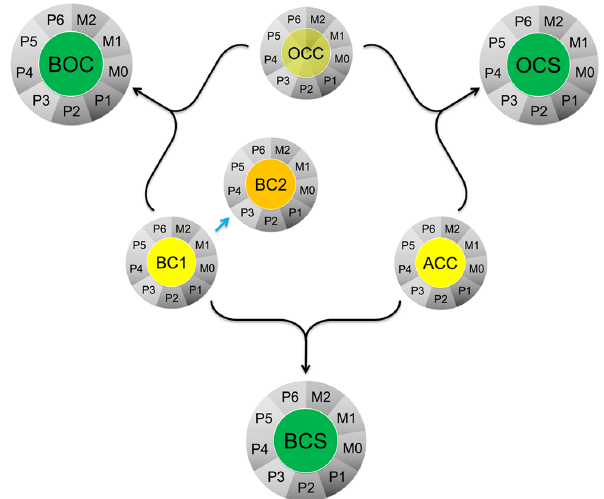
Figure 1. Schematic showing coagulation pathways among organics-containing aerosol populations as colored circles, with nine organic VBS species condensed as grey outer circles. In yel- low are the emitted donor aerosol populations, and in green are the mixed recipient populations. OCC has a semi-transparent yellow core because it is actually emitted as the VBS species that can serve as condensation medium for gaseous VBS species, represented by the grey outer circles. In orange is population BC2, which contains a >5% coating of sulfate and organics, which is formed rapidly from the growth of population BC1, which has <5% sulfate and/or organics